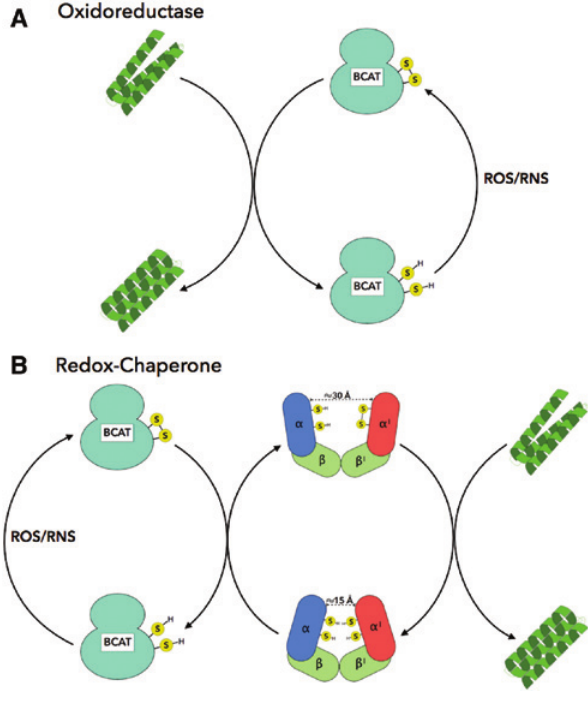
Figure 6: Redox activity of the hBCAT. (A) As an oxidoreductase, hBCAT can catalyse the introduction of disulphide bonds, refolding proteins. This reaction is redox regu- lated. (B) As a chaperone, it is hypothesised that through a thiol disulphide exchange mechanism, hBCATm can oxidize PDI, becom- ing reduced and promoting the refolding of substrate proteins. Of note is the increase in rate of refolding when hBCATm is incubated with PDI during refolding of reduced denatured